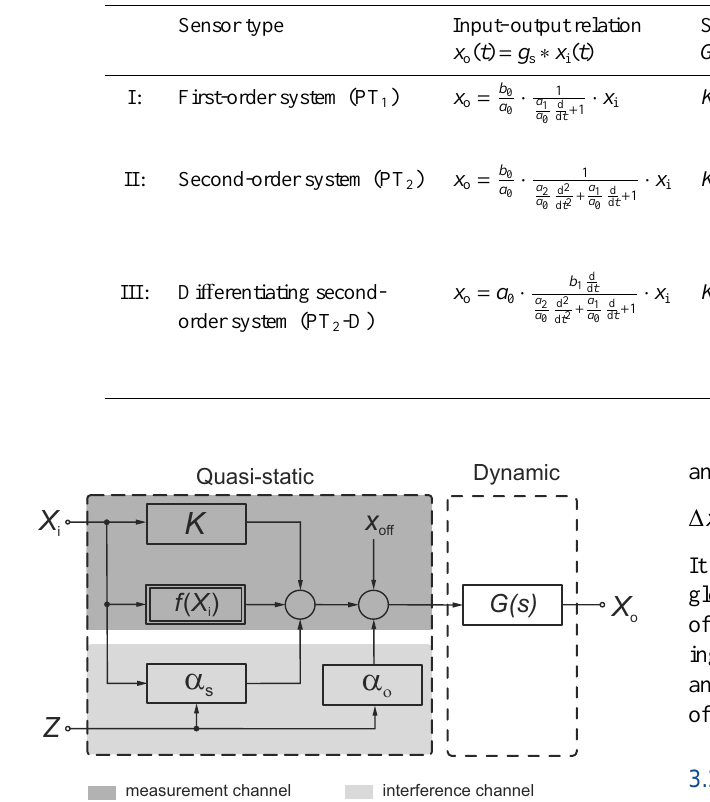
Figure 7. General sensor model with measurand X i and sensor out- put X o sub-divided in a quasi-static and a dynamic part and com- prising a measurement and an interference channel. K intrinsic ideal sensitivity, G ( s ) normalized sensor transfer function, α s sensitivity coe ffi cient, Z interference quantity altering the ideal sensitivity, f non-linearities in the transfer characteristics, x o ff sensor o ff set, α o o ff set coe ffi